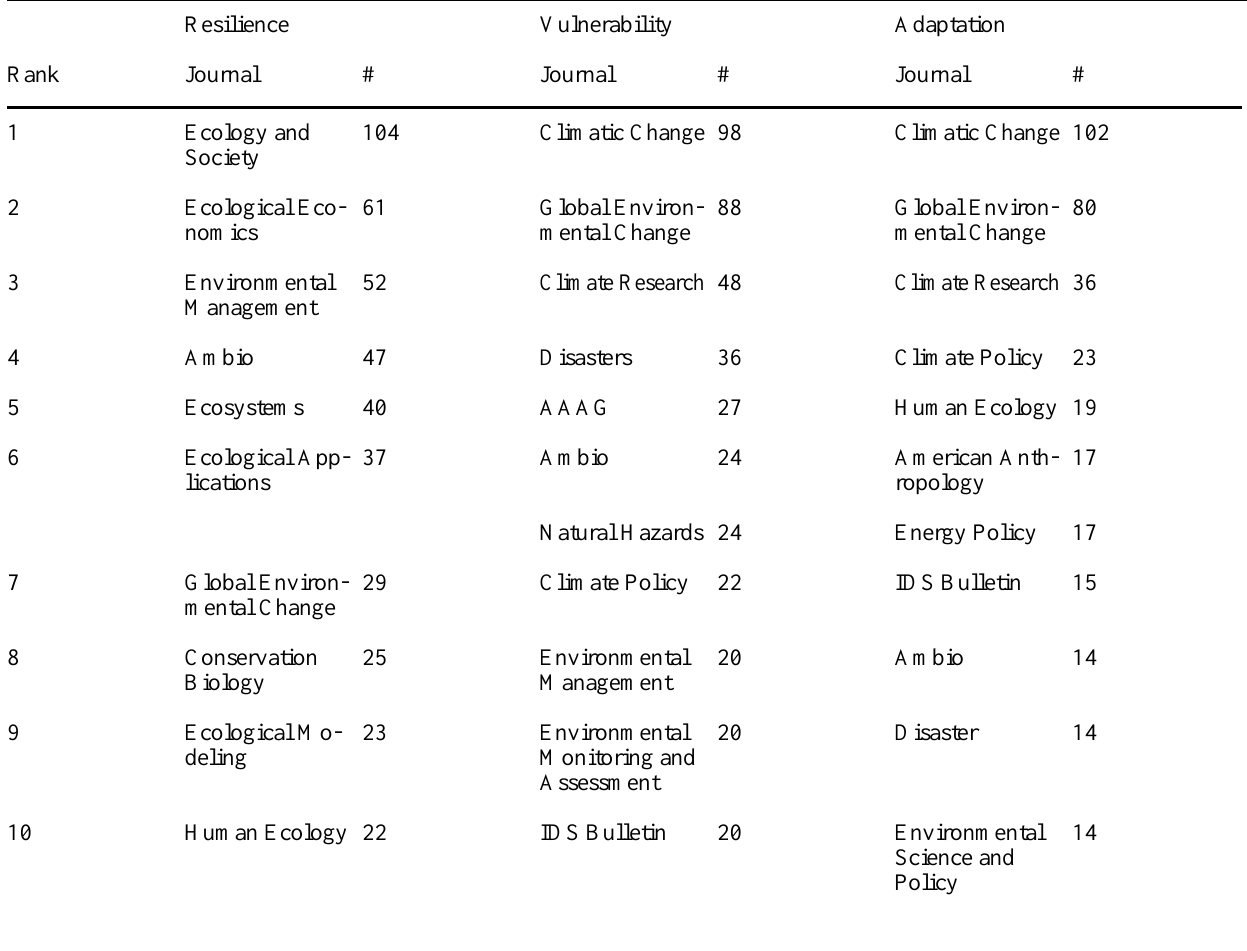
Table 3. The top ten journals with the greatest number of papers in resilience, vulnerability, and adaptation over the period 1977–2007. (The # symbol refers to the number of